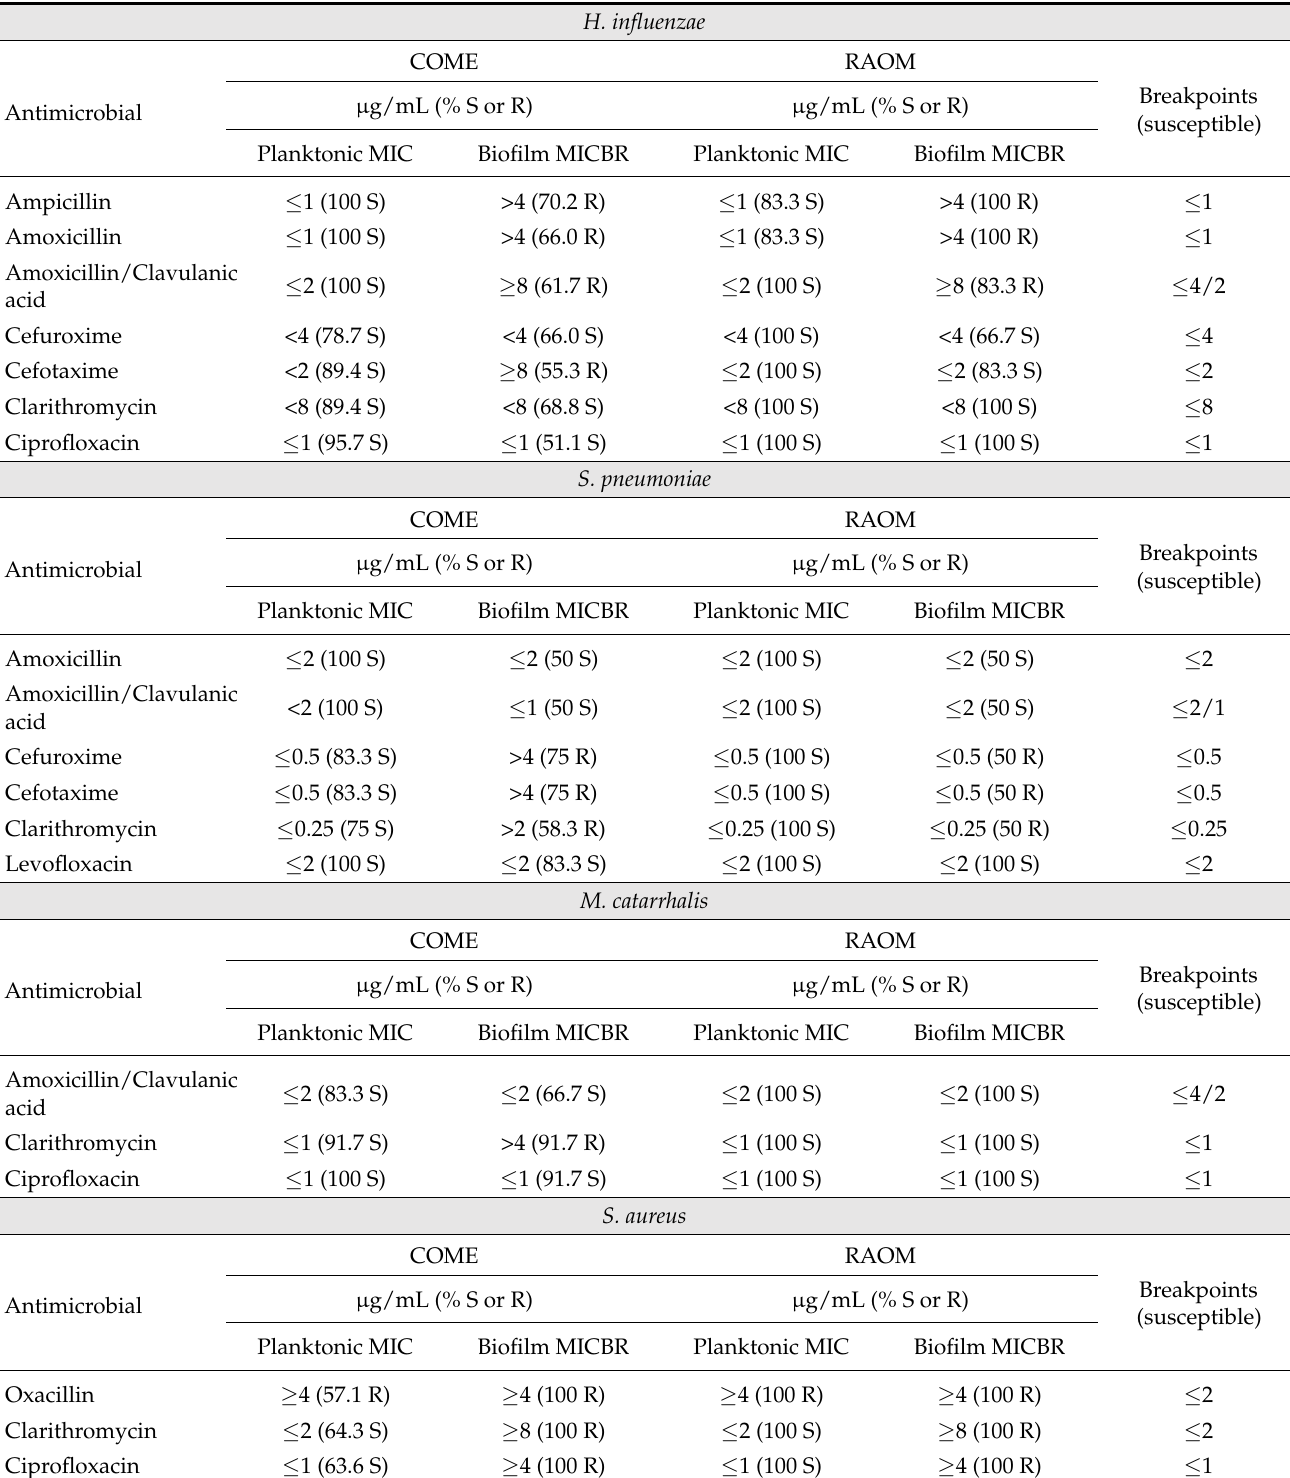
Table 4. Planktonic MIC and Biofilm MICBR of the antimicrobials of all isolates for COME and RAOM. H.